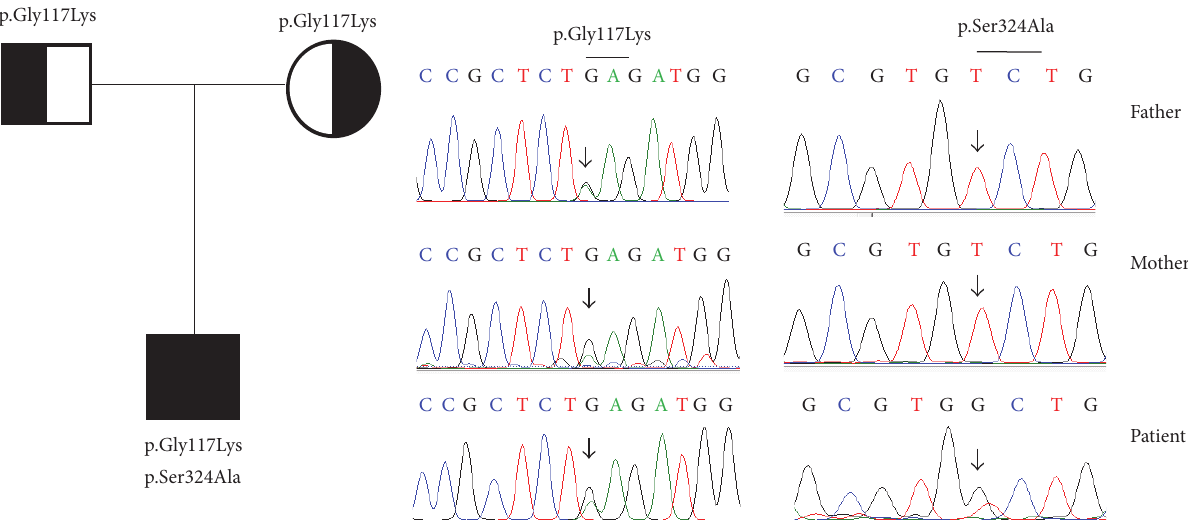
Figure 2: Mutations of the NPHS1 gene were identified by sequencing in patient 2 and his parents. The pedigree and mutations of the NPHS1 gene were identified in the family of patient 2, including a heterozygous variant p.Glu117Lys and a “de novo” heterozygous mutation